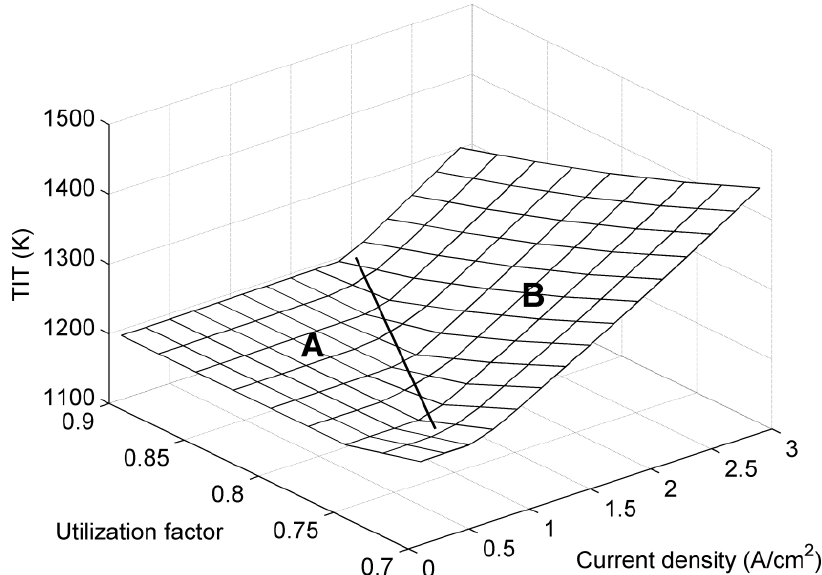
= 600 °C and r = FC p